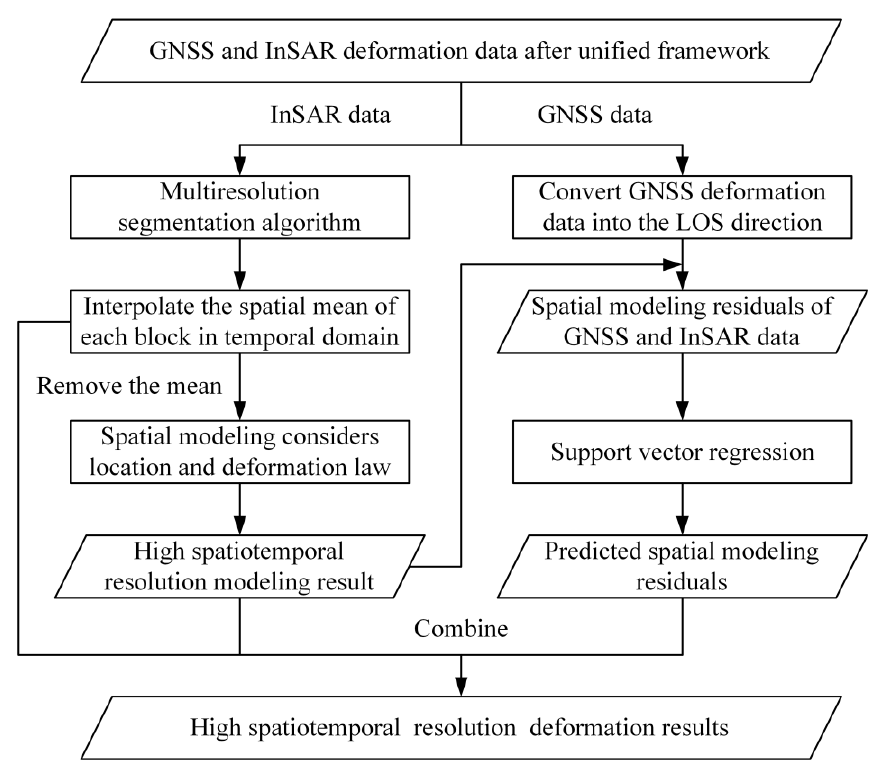
Figure 1. Flow chart for the fusion of global navigation satellite system (GNSS) and interferometric synthetic aperture radar (InSAR) deformation data.